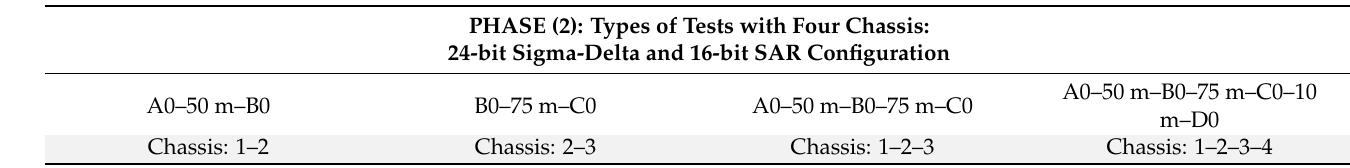
Table 2. Classification of test types with four chassis.